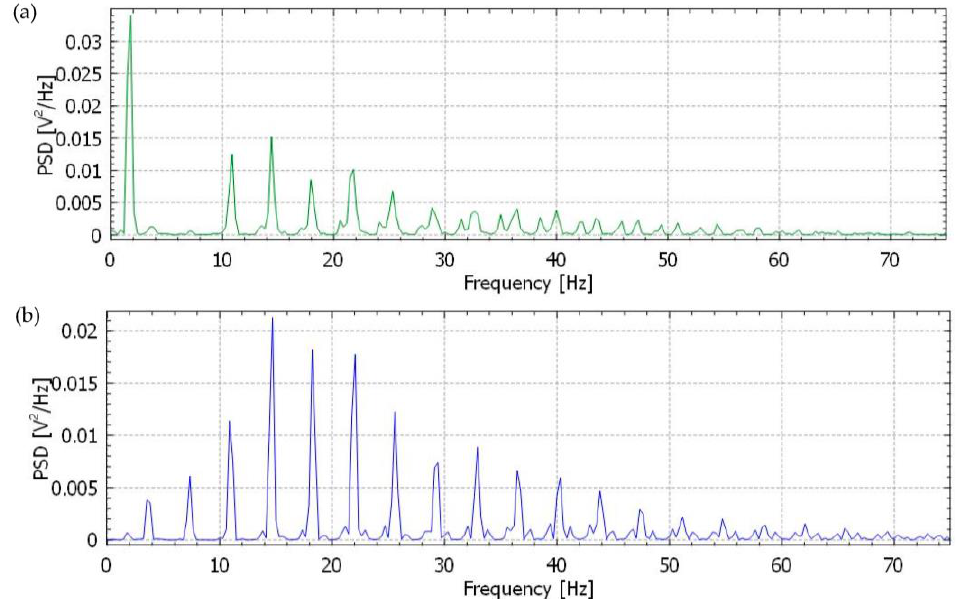
Figure 12. Comparison of the frequency response of filtered ECG signals from the Ag/AgCl and GN-based electrode up to 75 Hz. ( a ) Power spectral density (PSD) of ECG recordings (from Figure 8a) for the Ag/AgCl electrode; ( b ) PSD of ECG recordings (from Figure 8c) for GN-based electrode.